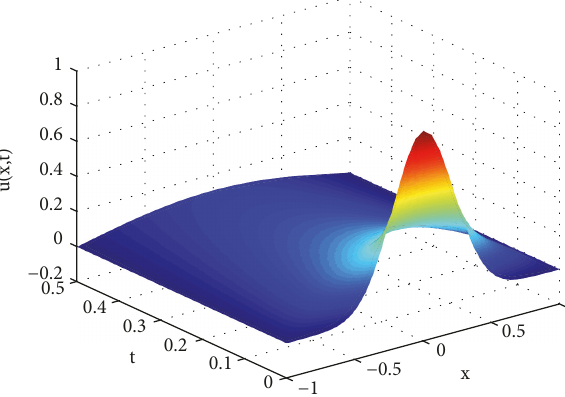
Figure 9: Fractional Brownian motion with 𝛼 = 1.5, 𝛽 = 1